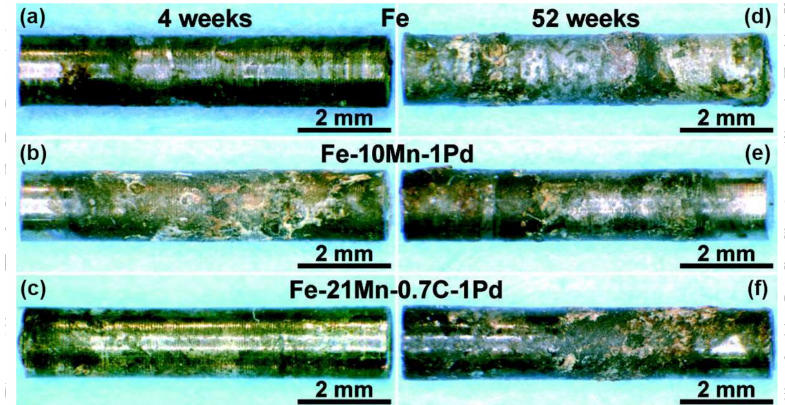
Figure 8. Optical micrographs of the wires after implantation for ( a – c ) 4 weeks and ( d – f ) 52 weeks of ( a , d ) pure Fe, ( b , e ) Fe–10Mn–1Pd and ( c , f ) Fe–21Mn–0.7C–1Pd, reproduced with permission from [48], Elsevier,